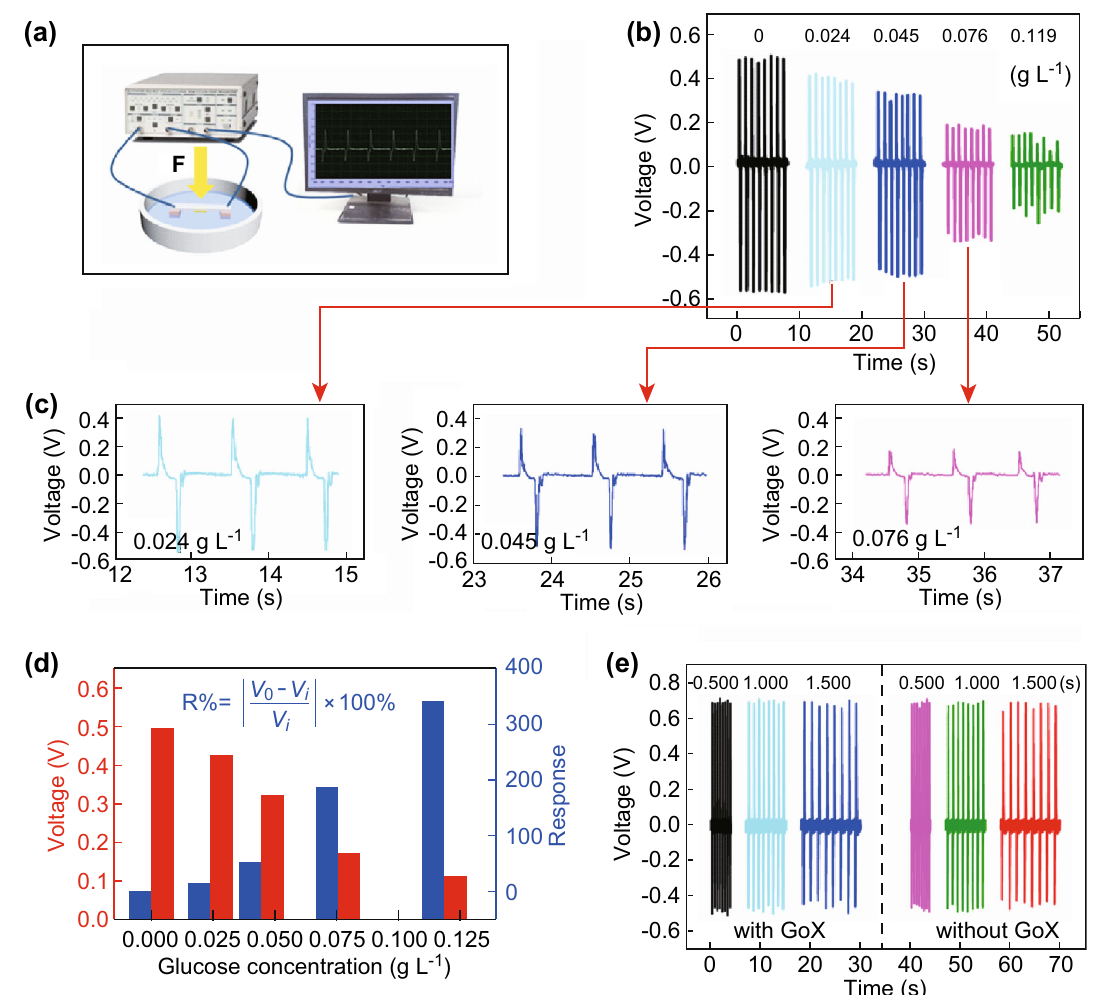
Fig. 3 a The measurement system. b The outputting piezoelectric voltage of self-powered implantable skin-like glucometer in different concentrations of glucose solution. The applied force is 21 N. c The enlarged views of the outputting piezoelectric voltage against 0.024, 0.45, and 0.076 g L - 1 glucose solution. d The outputting piezoelectric voltage and the response of the device against different glucose solution concentration. e The piezoelectric voltage of the skin-like glucometer with and without GOx modification in air with different force